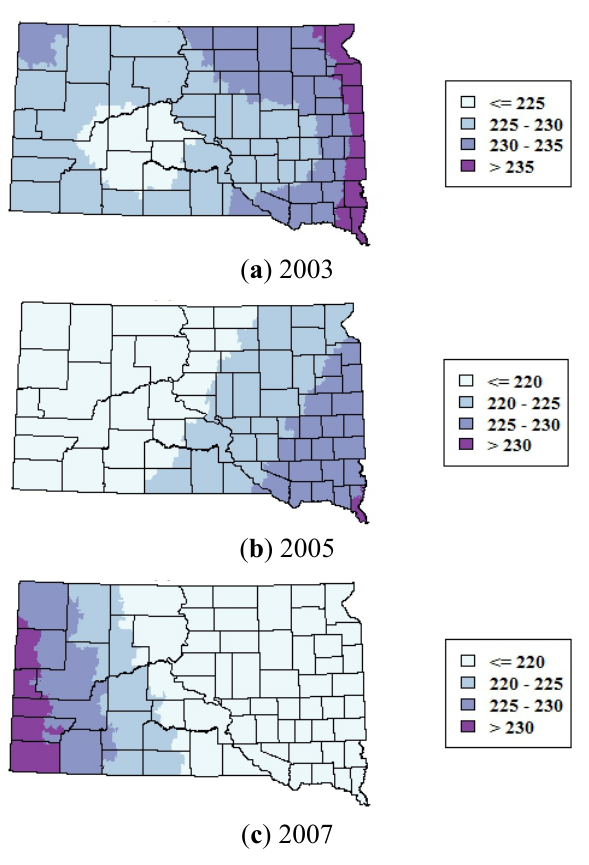
Figure 8. Smoothed maps of the mean day of year of WNV cases for 2003, 2005, and 2007. Maps were generated by using generalized additive models to predict the DOY as a smoothed function of the spatial coordinates of the